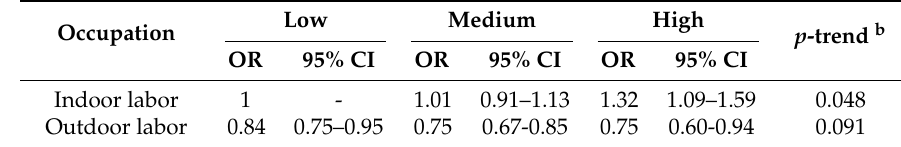
Table 3. Odds ratios (ORs) with 95% confidence intervals (CI) obtained from multivariable logistic regression a .